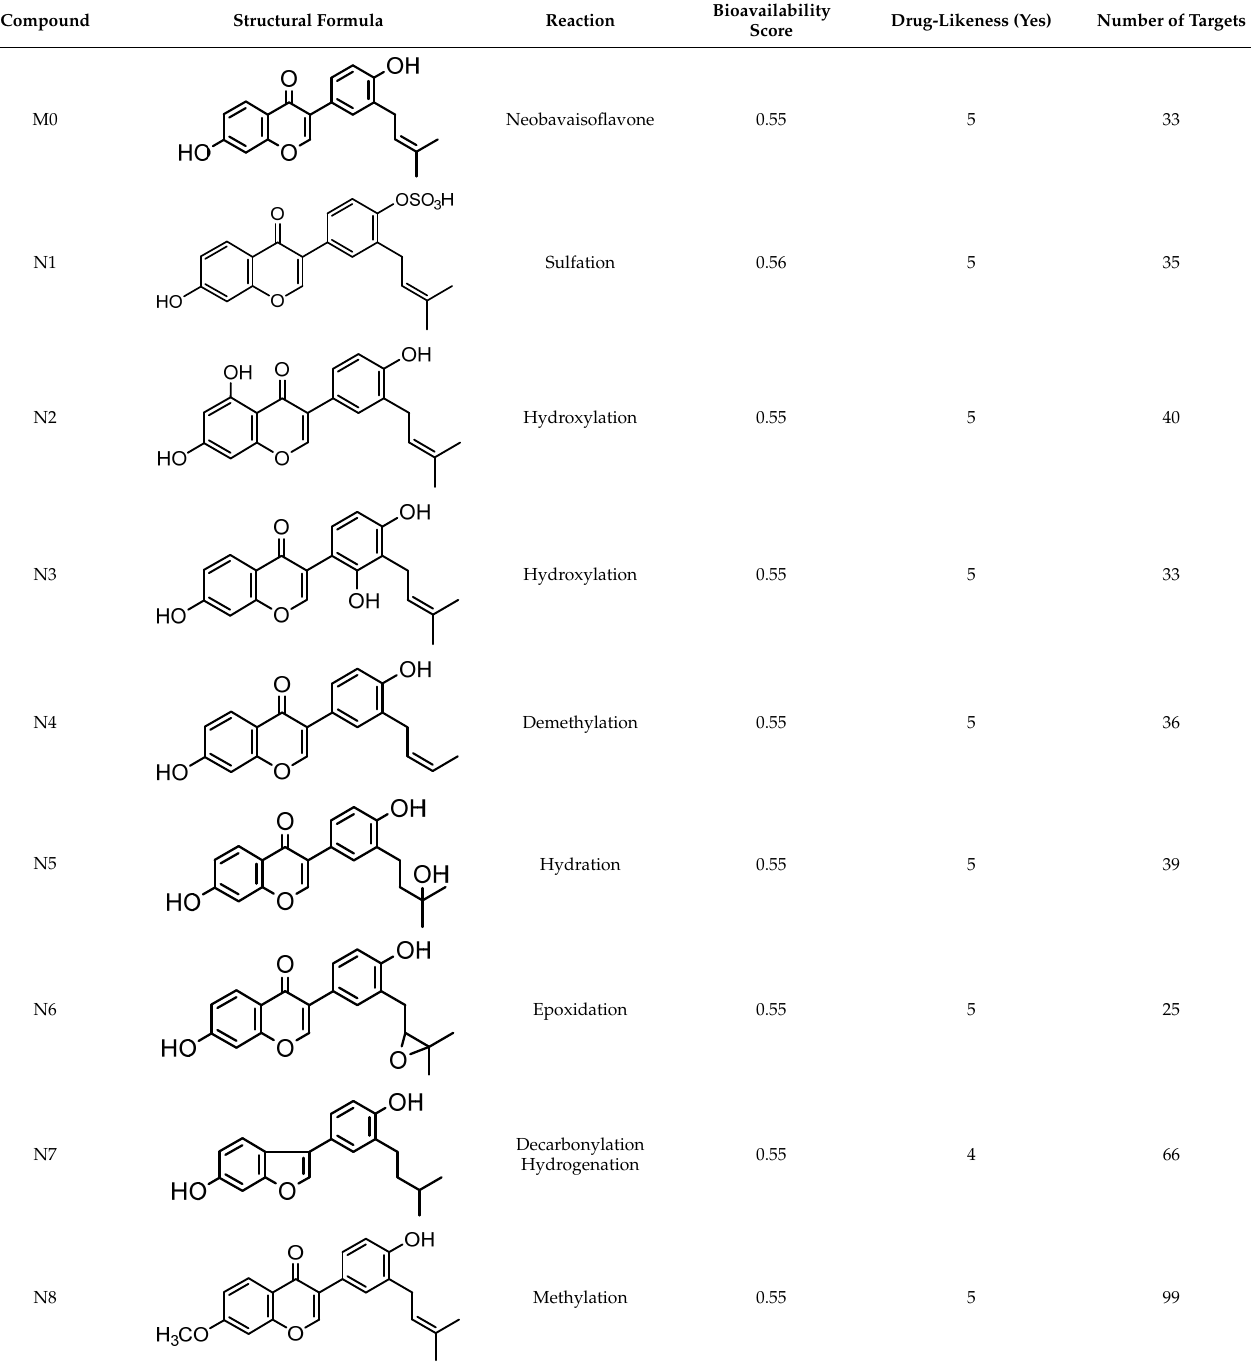
Table 3. Ingredient screening list.